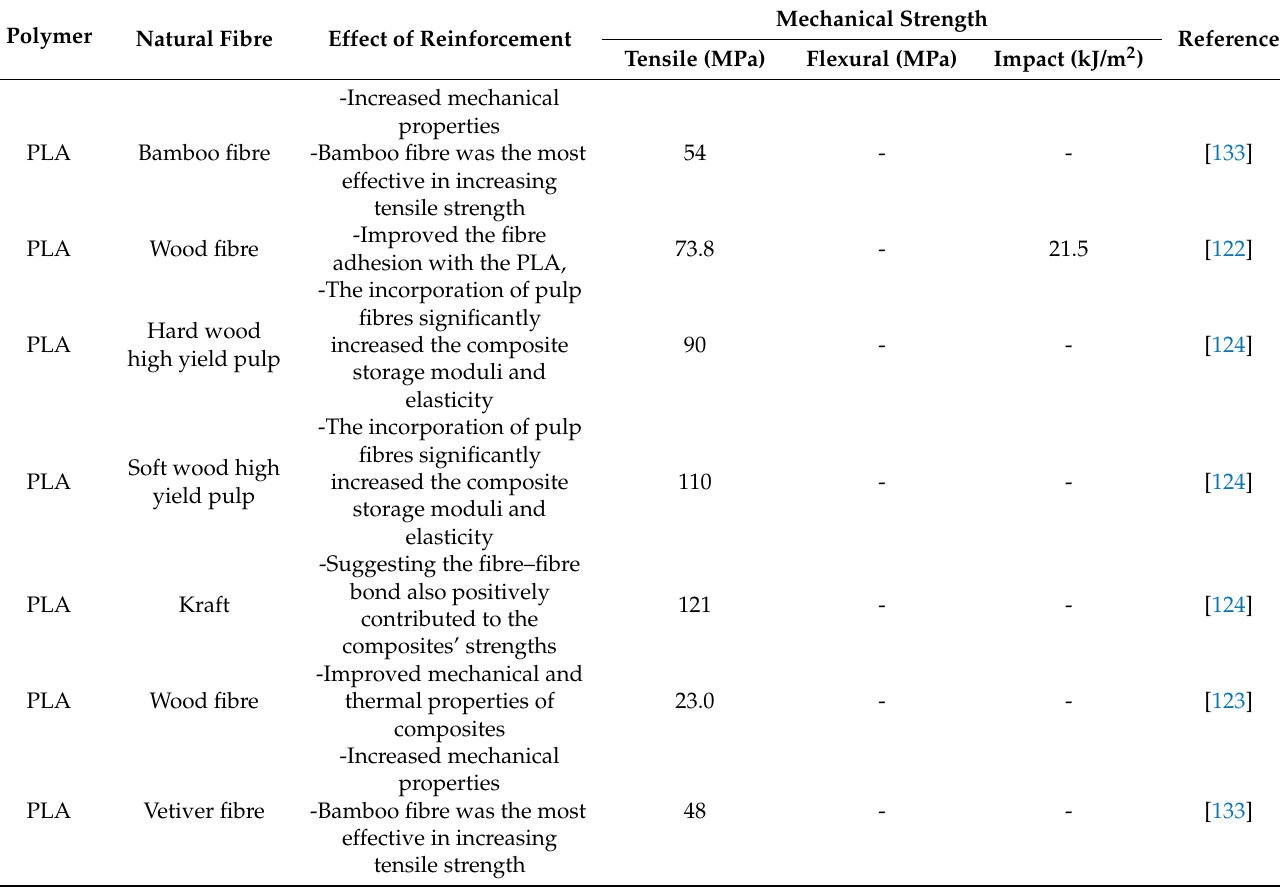
Table 2. Reported work on natural fibre reinforced PLA